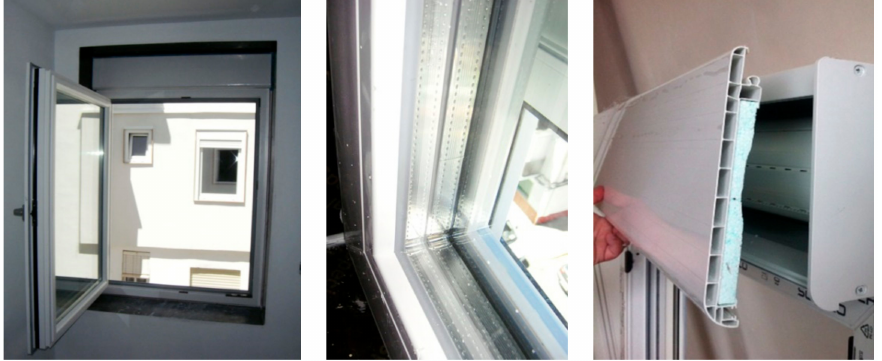
Figure 13. New façade